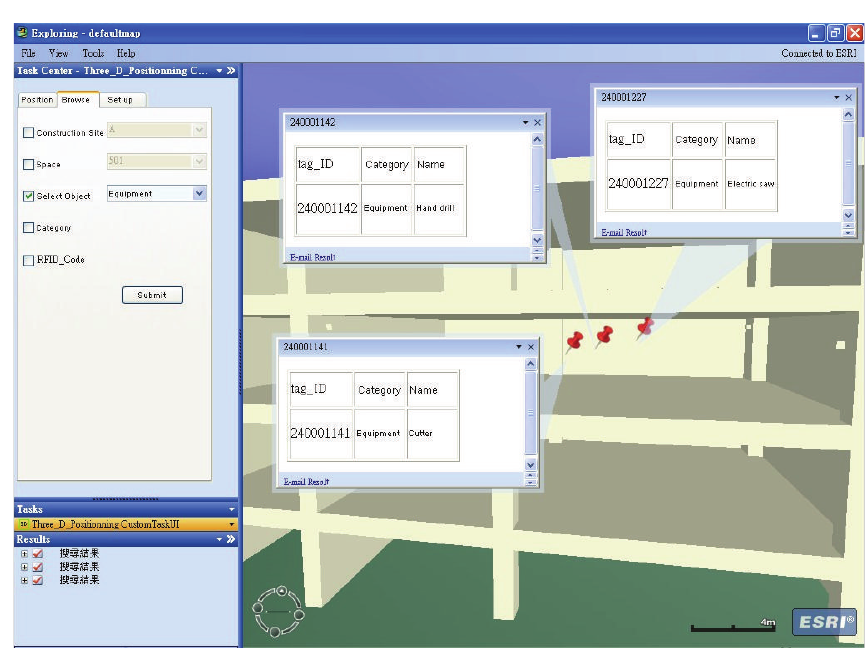
Figure 13: Browsing construction object